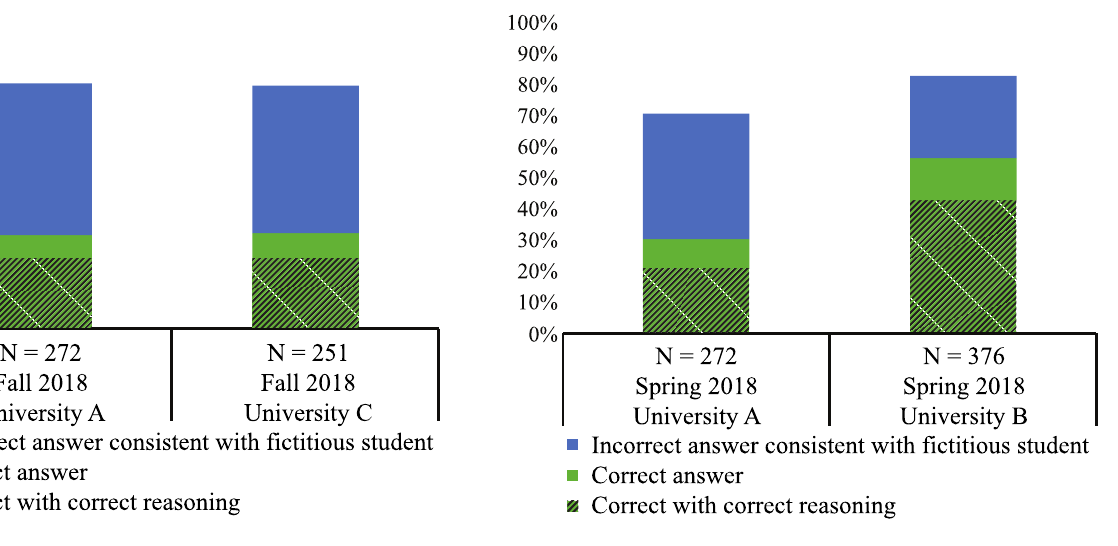
FIG. 7. Student responses on the electric circuits base task. Shaded areas represent correct answers supported with correct reasoning. All other regions represent answers only, irrespective of the reasoning given. Totals do not sum to 100% because answer choices not aligned with one of the fictitious students are not